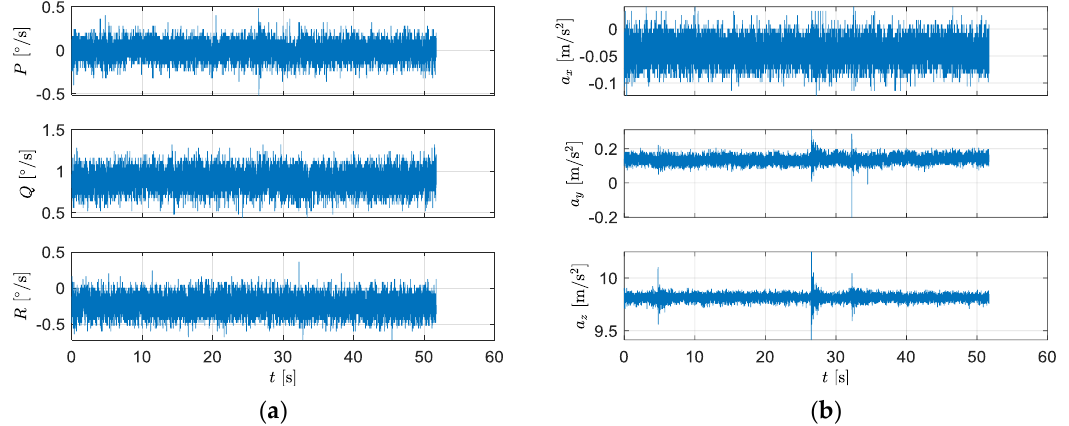
Figure 8. Example noise of the sensors from static measurements: ( a ) gyroscopes; ( b ) accelerometers.